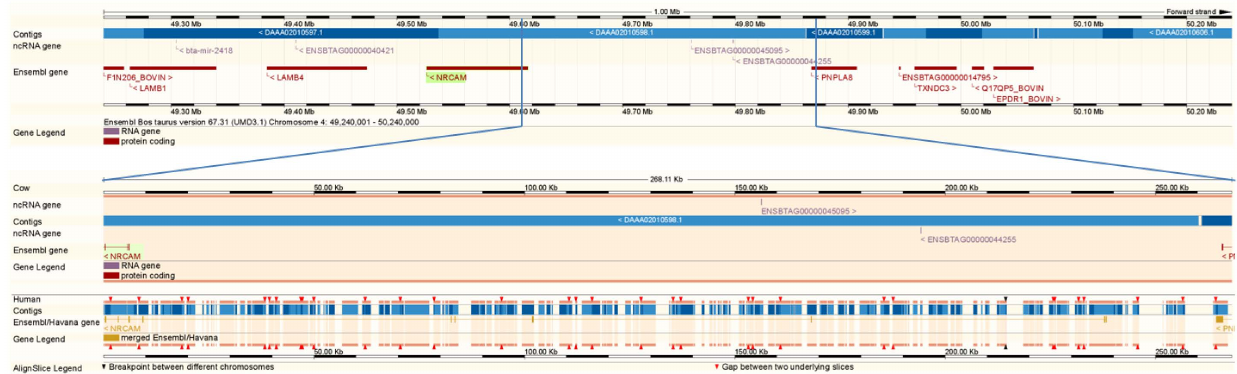
Figure 3. Ensembl alignment of the bovine and human annotations from NRCAM to PNPLA8. Bottom portion of the figure highlights the annotated human exons (brown cross hatch) for NRCAM which align to an unannotated portion of the bovine genome. UMD3.1 assembly